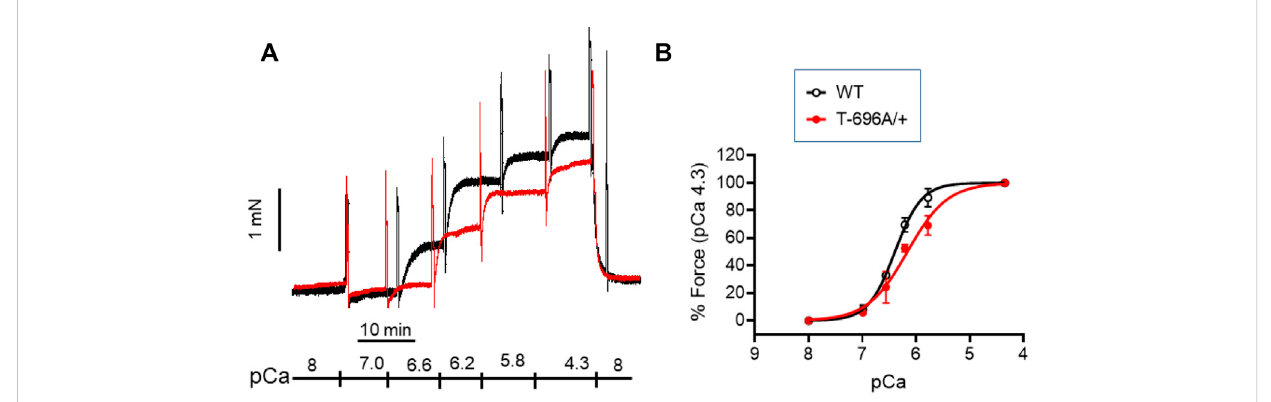
FIGURE 3 Ca 2+ -activated contraction of basilar arteries from young WT- and MYPT1-T696A/+-mice. Original force tracing (A) and statistical summary (B) depicting Ca 2+ -activated contraction of young BA from WT- and MYPT1-T696A/+-mice ( n = 4 – 5). Tone normalized to pCa 4.3 accepted as 100%.